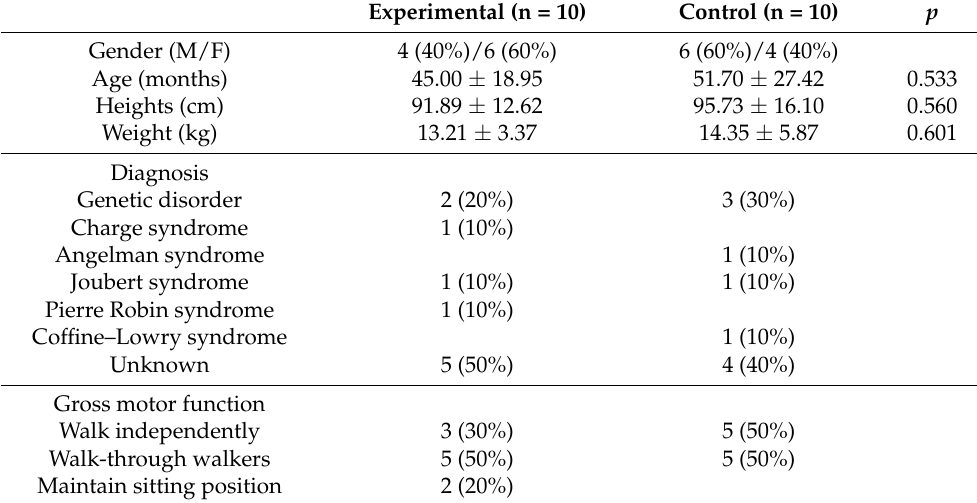
Table 1. General and clinical characteristics of the participants (N = 20).